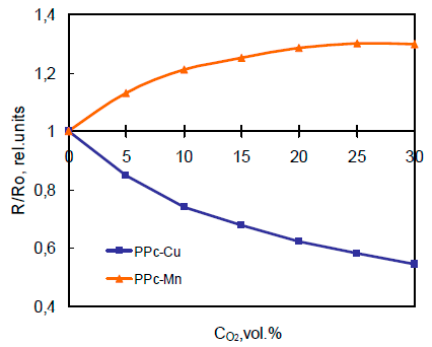
Figure 4. Typical resistance dependence on oxygen concentration for films at 200